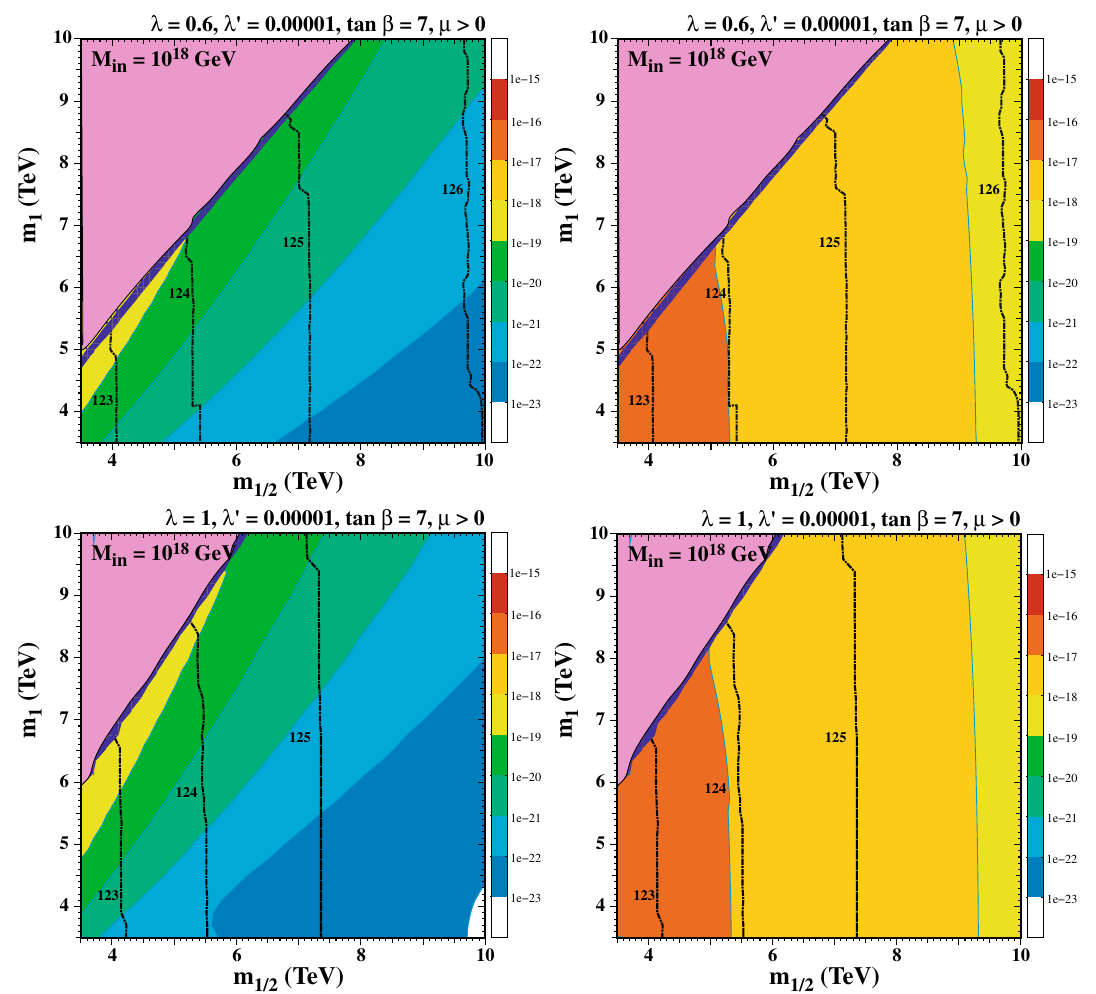
M4 with λ = 1 (lower panels). The color-coding for BR (μ → e γ) is indicated in the bars beside the